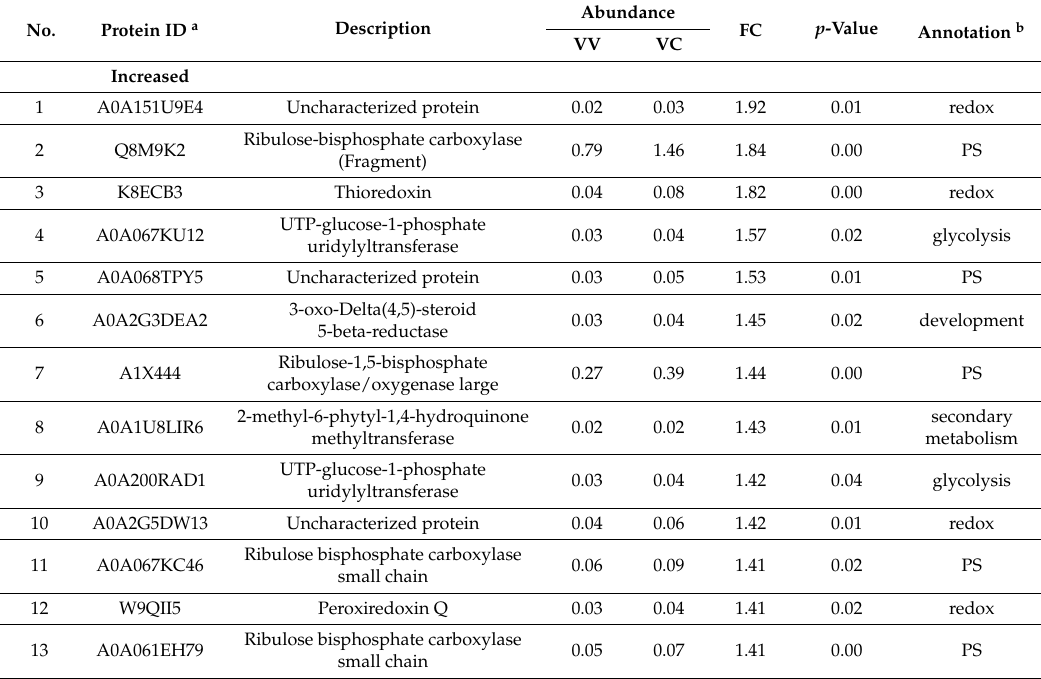
Table 2. Differential Expressed Proteins in Clematis terniflora DC. between VV and VC at starting point (fold change >